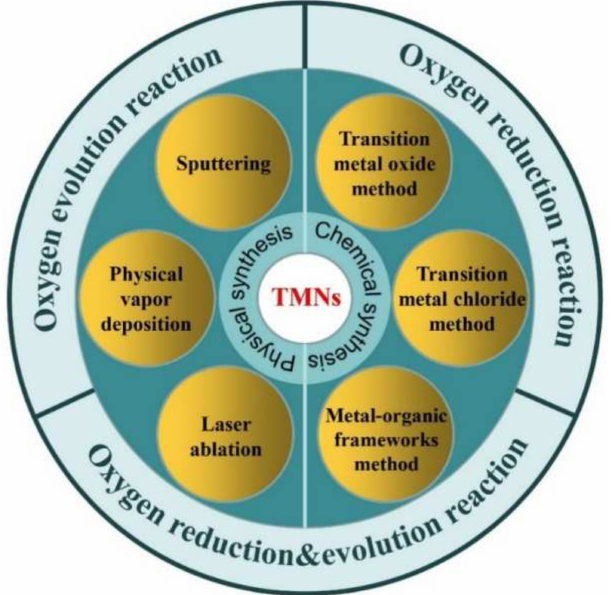
Figure 1. Simple diagram of the synthetic methods and applications of